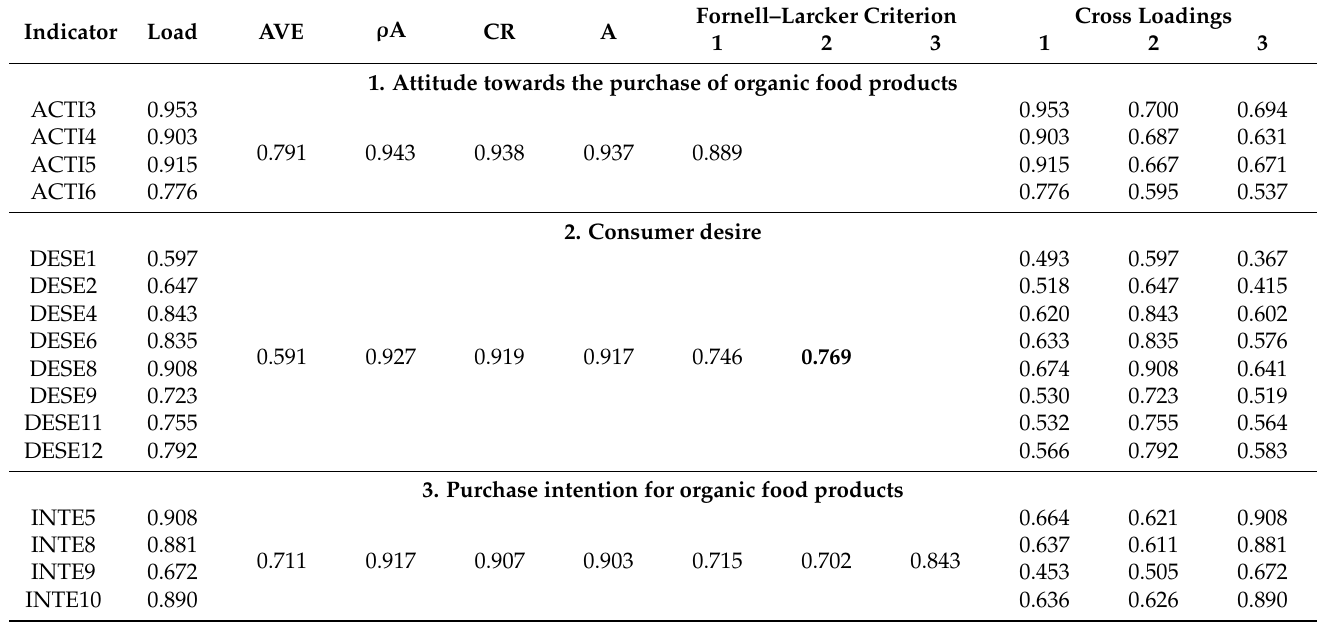
AVE- average variance extracted, ρ A- Dijkstra–Henseler’s value, α - Cronbach’s alpha coefficient, CR- composite reliability. The square root of the AVE is on the diagonal (bold). Source: own elaboration with results obtained from the software Smart Partial Least Squares (PLS) version 3